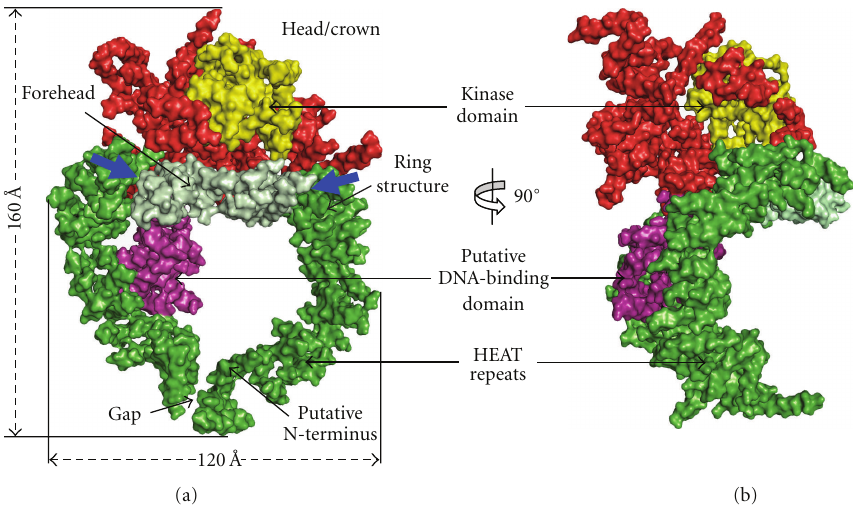
Figure 6: Crystal structure of DNA-PKcs. Molecular surface of the DNA-PKcs structure showing (a) front and (b) side views. Also shown in (a), is the overall size of DNA-PKcs with the potential flexible sites indicated in blue arrows. The molecule is colour coded as follows: the ring structure that is predominantly HEAT repeats is green; the forehead that is part of the ring structure is light green; the putative DNA binding domain is magenta; the larger C-terminal part that includes the FAT and FATC domains is red, and the kinase domain is yellow.